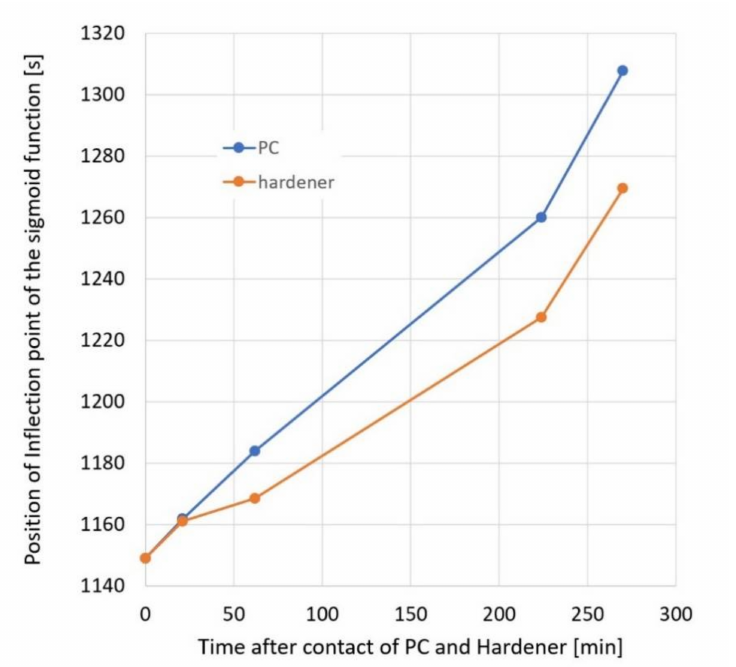
Figure A6. Depending on the contact time of hardener on the PC film, the respective inflection points of the falling (PC) and rising (hardener) sigmoid functions shift. From this it can be concluded that both the hardener penetrates the PC and the PC dissolves in the hardener.